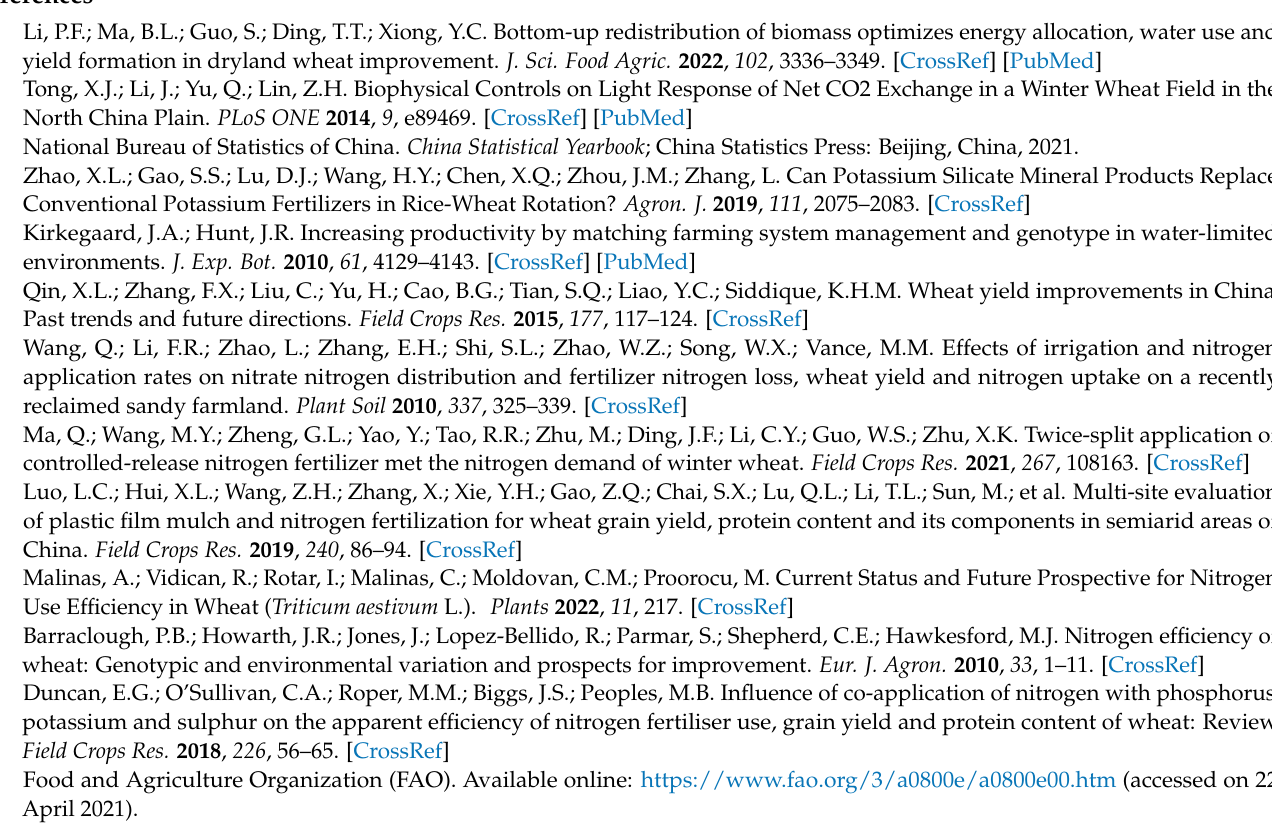
Figure A3. Correlation of nitrogen accumulation with root oxidation activity, root total absorbing surface area, and root active absorbing surface area. N1, nitrogen accumulation at jointing; N2, nitrogen accumulation at booting; N3, nitrogen accumulation at anthesis; N4, nitrogen accumulation at maturity; R1, root oxidation activity at jointing; R2, root oxidation activity at booting; R3, root oxidation activity at anthesis; R4, root oxidation activity at maturity; R5, root total absorbing surface area at jointing; R6, root total absorbing surface area at booting; R7, root total absorbing surface area at anthesis; R8, root total absorbing surface area at maturity; R9, root active absorbing surface area at jointing; R10, root active absorbing surface area at booting; R11, root active absorbing surface area at anthesis; R12 root active absorbing surface area at maturity. The darker the color, the higher the correlation. *, **, and *** indicate the significant differences at p < 0.05, p < 0.01, and p < 0.001, respectively.